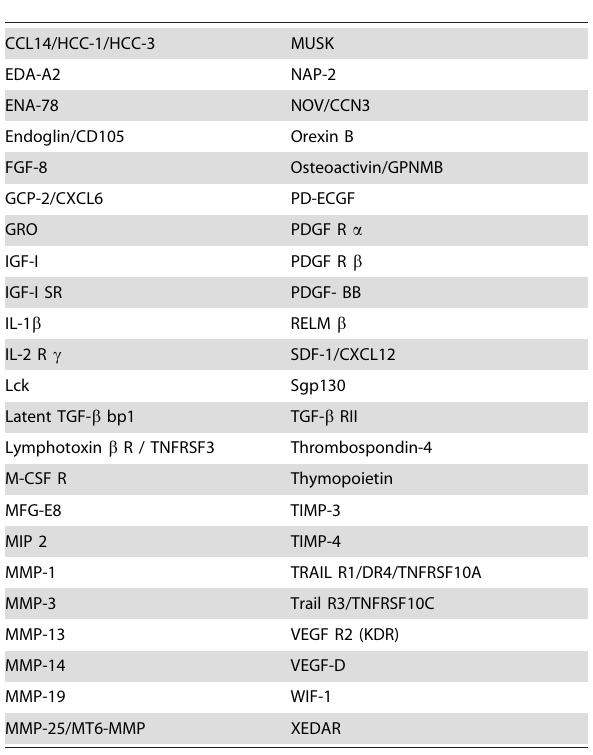
Table 1. Secreted proteins that were increased 5-fold or higher in co-culture conditioned medium (CM) compared to CM from naı¨ve